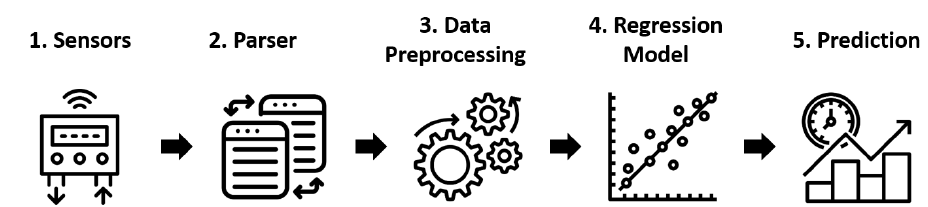
Figure 1. General Concept.